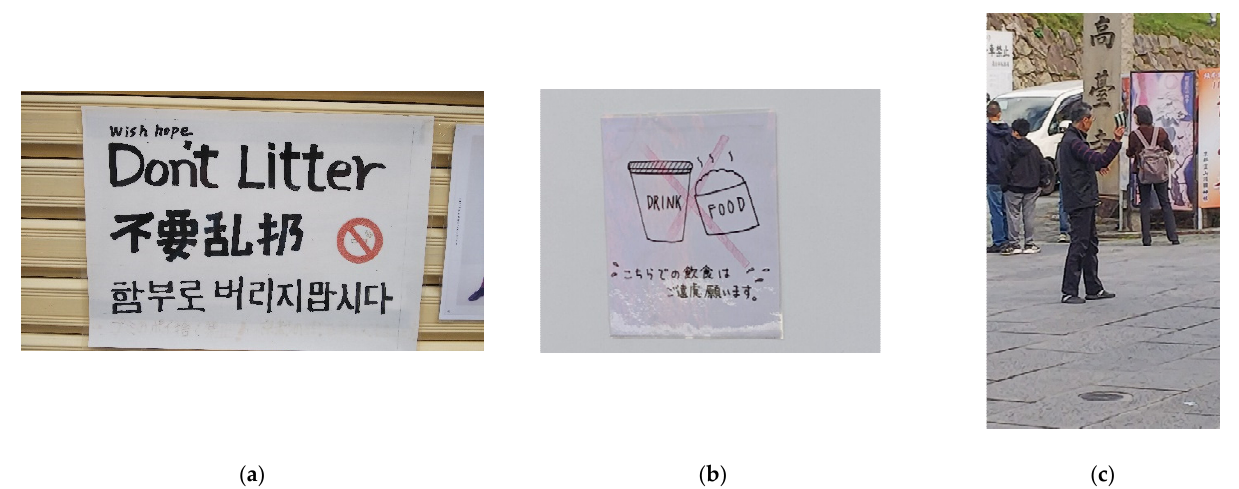
Figure 3. Examples of local residents’ actions (Source: Authors) ( a ) Kyoto—3 October 2020, ( b ) Kamakura—31 March 2021, ( c ) Kyoto—20 November 2020.